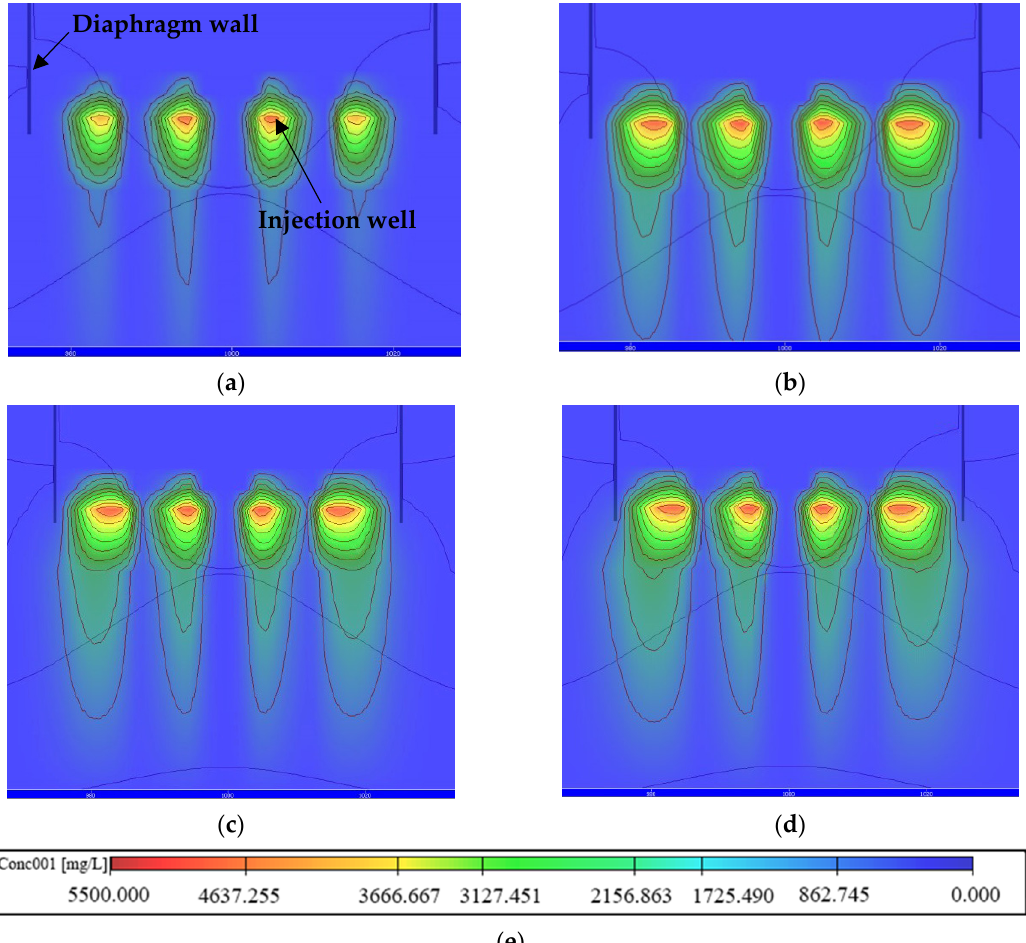
Figure 9. Vertical migration of S. pasteurii in different time periods: ( a ) 1d; ( b ) 2d; ( c ) 3d; ( d ) 4d; ( e )